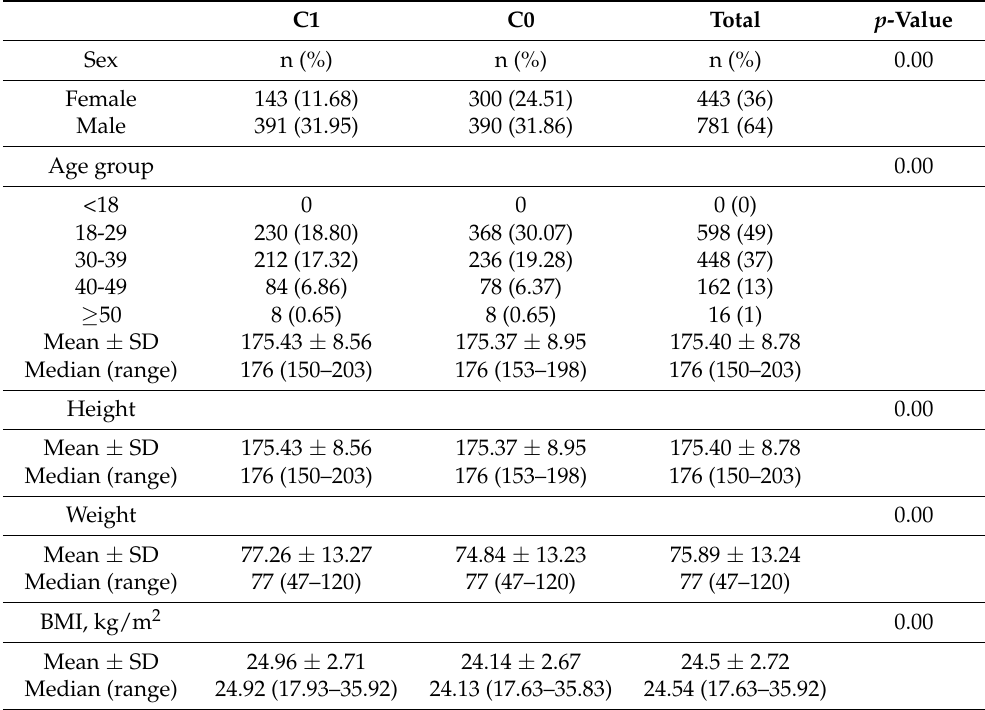
Table 1. Demographic data of the